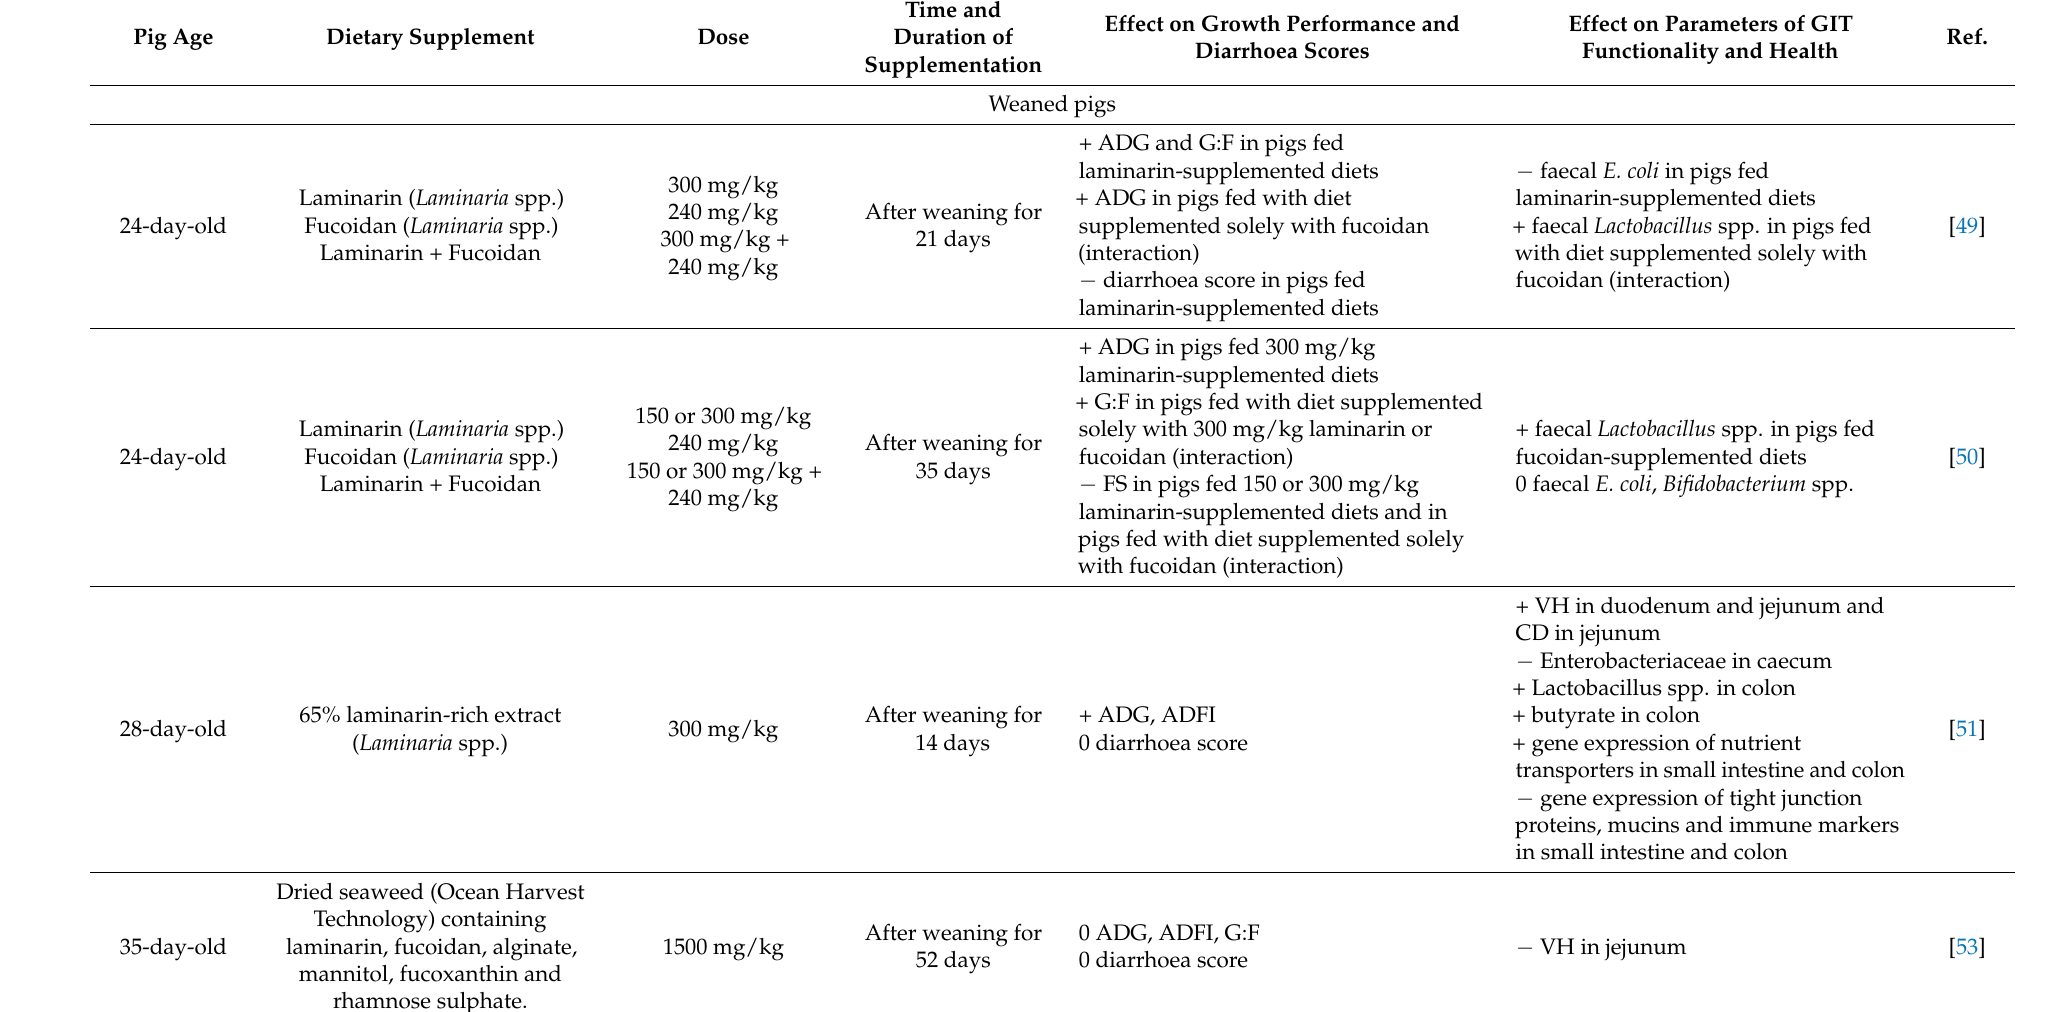
Table 1. Effect of seaweed supplement on growth performae, diarrhoea scores and parameters of gastro intestinal